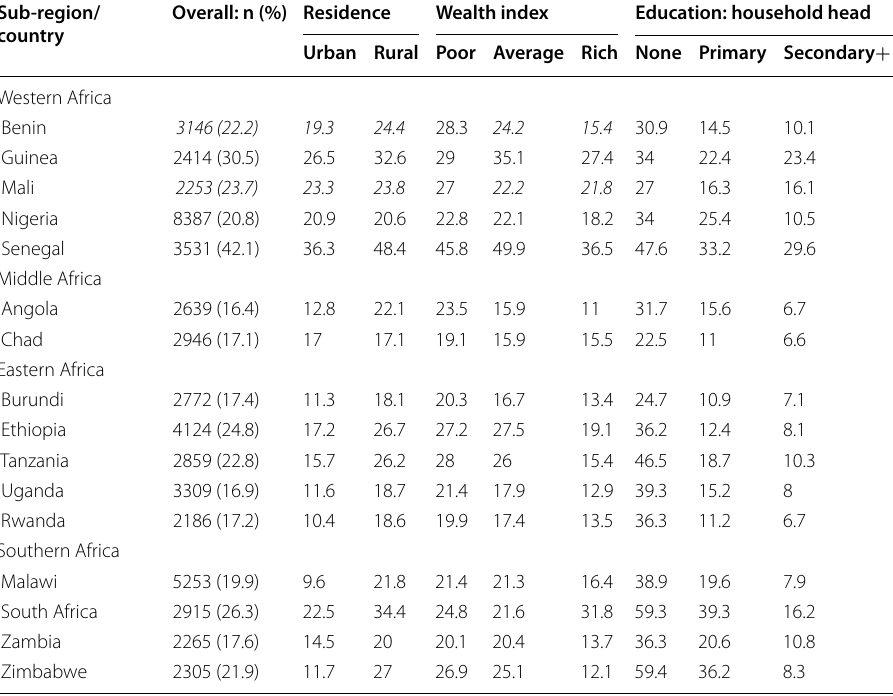
Table 5 Percentage of households with persons aged 60 and above in selected African countries Sub-region/ Overall: n (%) country